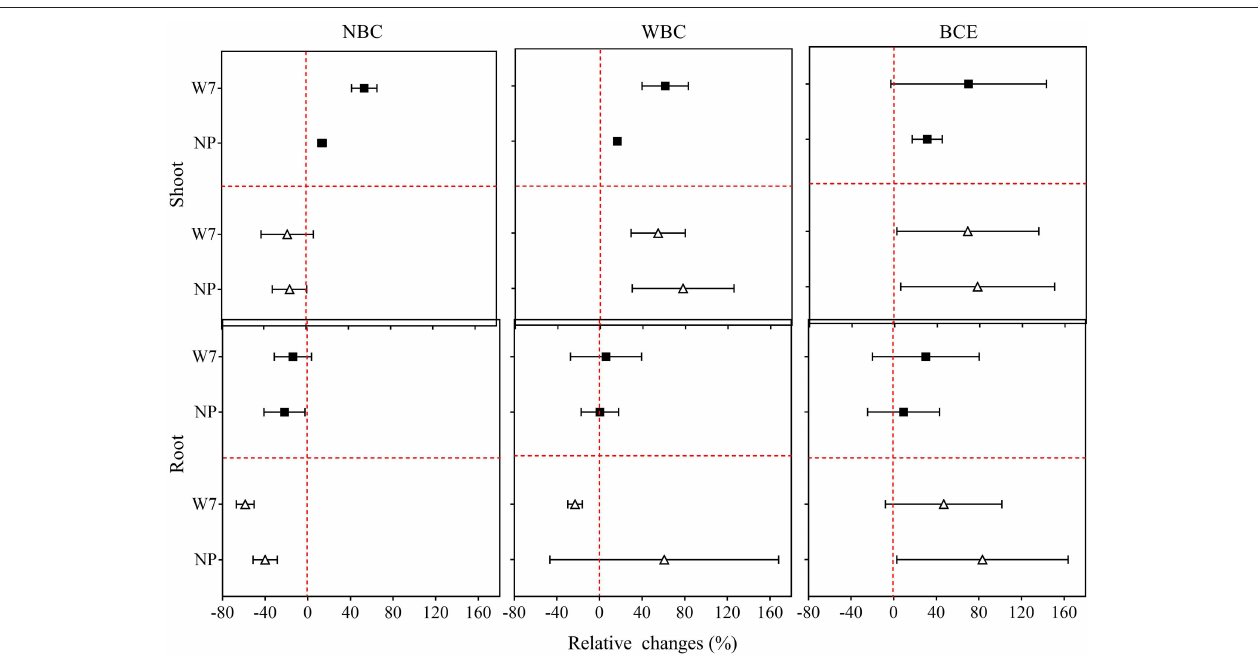
FIGURE 1 | Relative changes in fresh shoots and roots biomass of Wuyunjing 7 and Nipponbare with NBC, WBC, and BCE at a dosage of 0.05% (solid square) and 0.1% (hollow triangle) in Experiment 1 ( n = 4).